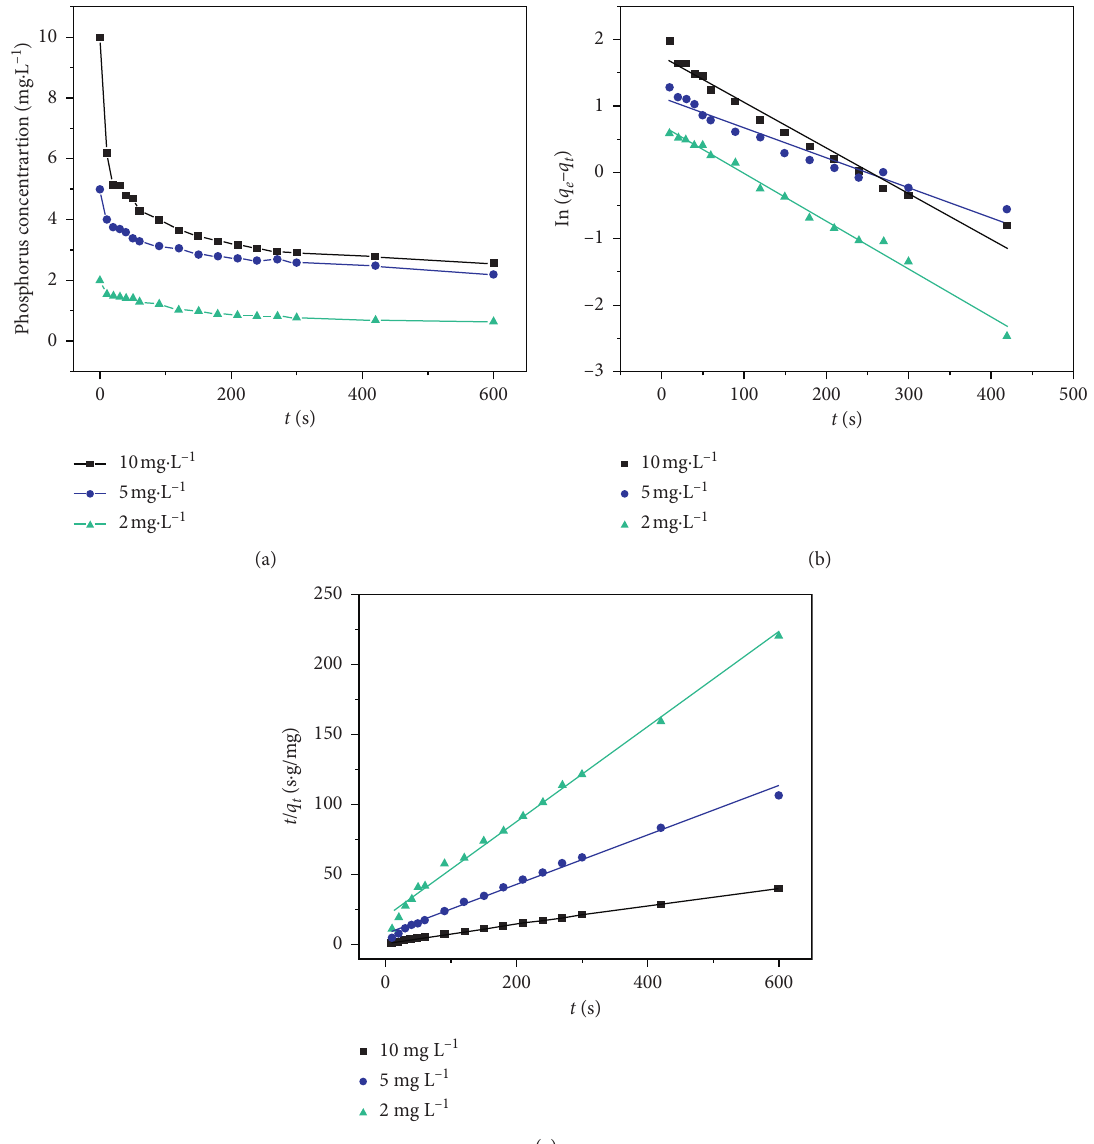
Figure 6: (a) Adsorption kinetics of phosphorus onto ceramsite; (b) pseudo-first-order model fitting; (c) pseudo-second-order model fitting